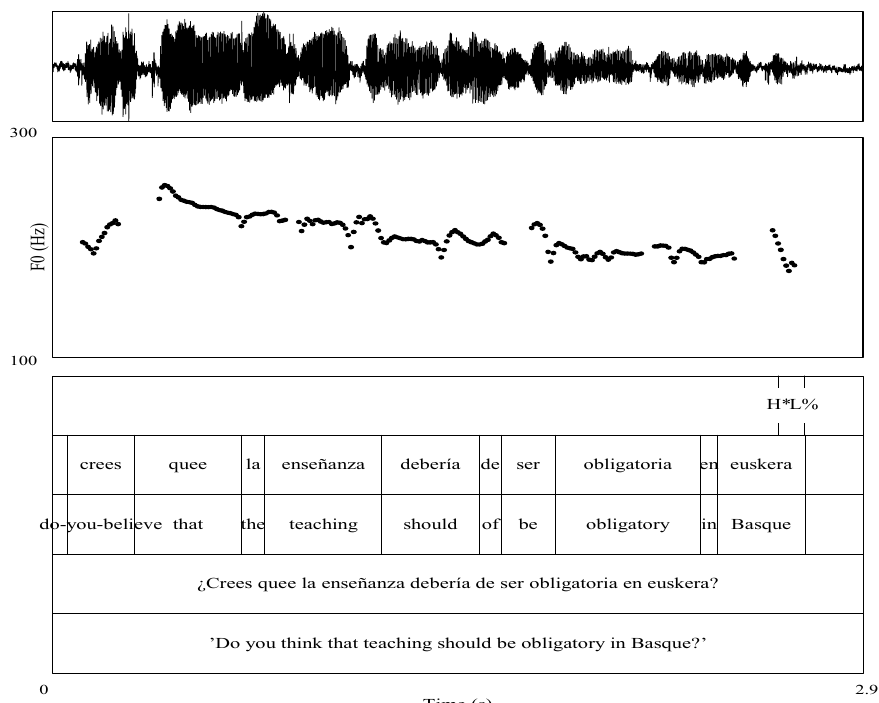
Figure 4. F0 contour of an absolute interrogative statement in Basque Spanish by a female L1 Basque/L2 Spanish speaker from Ibarra.